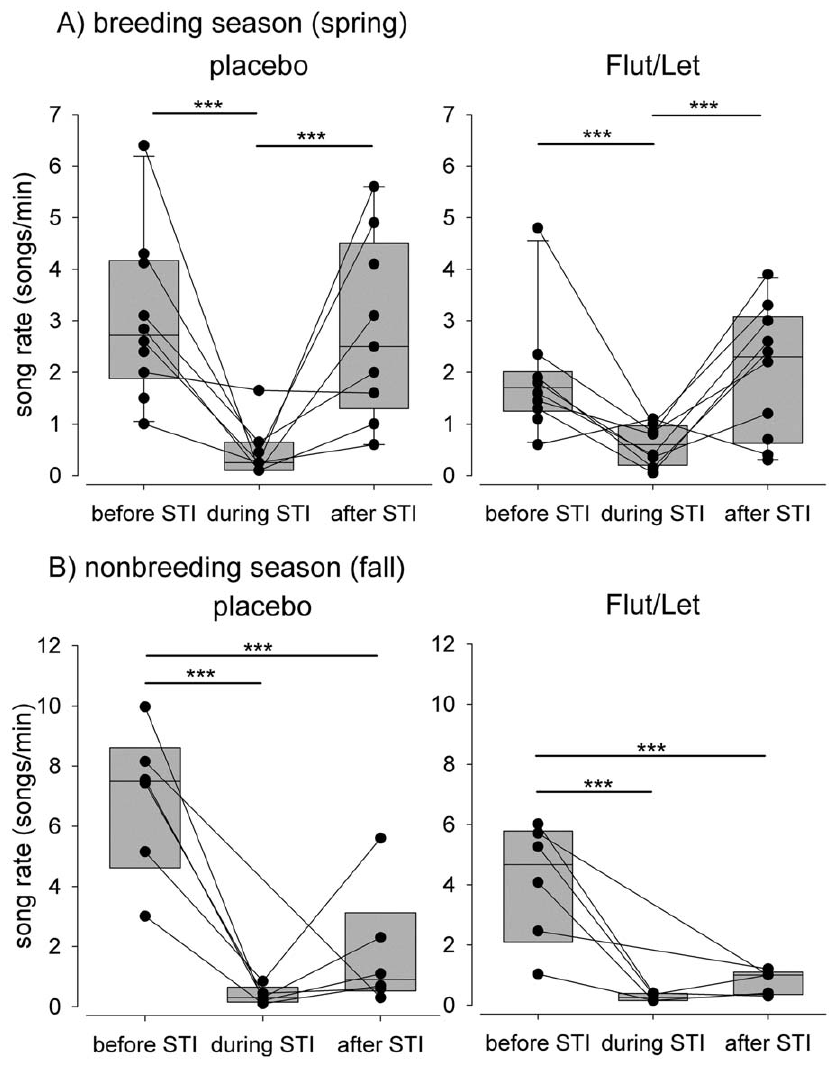
Figure 2. Song rate before, during and after the STI. Depicted separately for males treated with flutamide and letrozole (‘Flut/Let’) and placebo treated males (‘placebo’) in A) spring (n=10 per group) and B) in fall (n=6 per group). Each circle represents one individual male and measurements of the same male are connected by a line. Asterisks indicate significance (*** p , 0.001) and are according to a priori set contrasts (before vs. STI and before vs. after the STI). Mind the different scales in A and B.